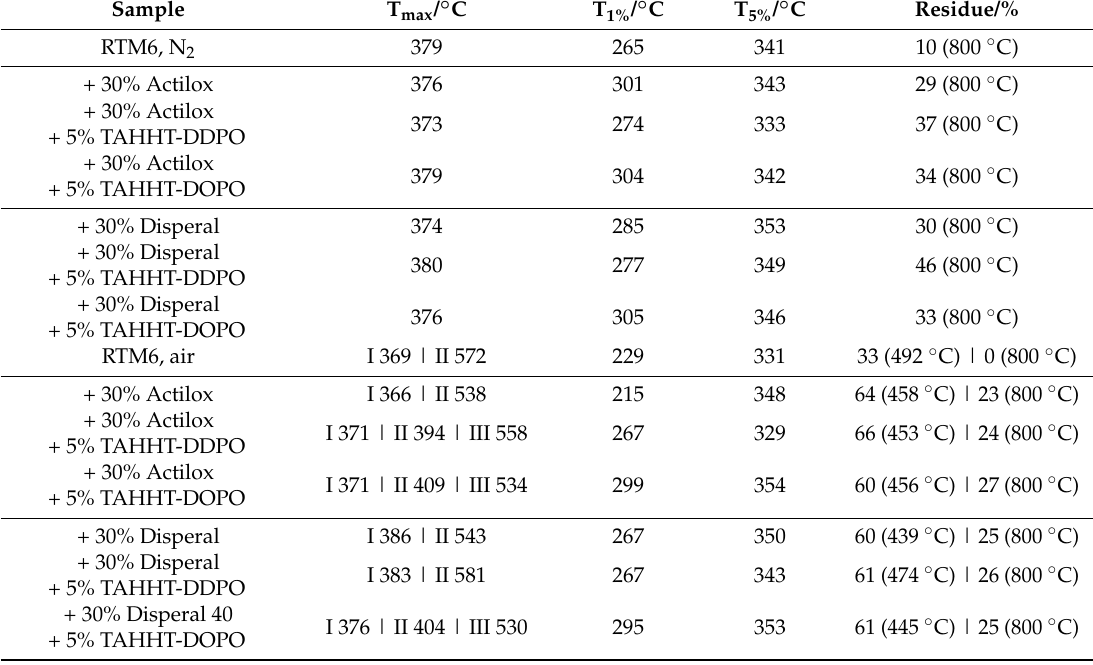
Table 9. T max , T 1% , T 5% and residue of boehmite and phosphorus containing polyacrylamides in RTM6 obtained by TG measurements under nitrogen atmosphere or synthetic air with a heating rate of 10 K · min − 1